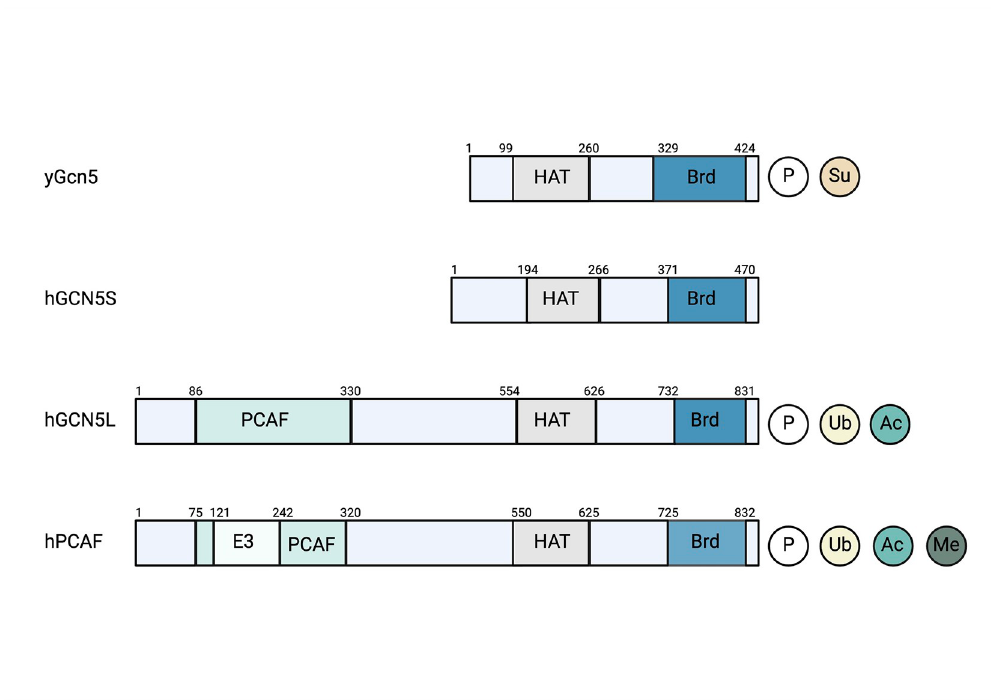
Fig 1. Domain structure of yeast Gcn5 compared to human GCN5 and PCAF homologs. Functional domains of yeast yGcn5 and mammalian hGCN5 and hPCAF outlining E3 ligase, PCAF homology, acetyl transferase (HAT), and bromodomain (Brd) regions with known PTMs: phosphorylation (P), sumoylation (Su), ubiquitylation (Ub), acetylation (Ac), and methylation (M). Created with BioRender.com.